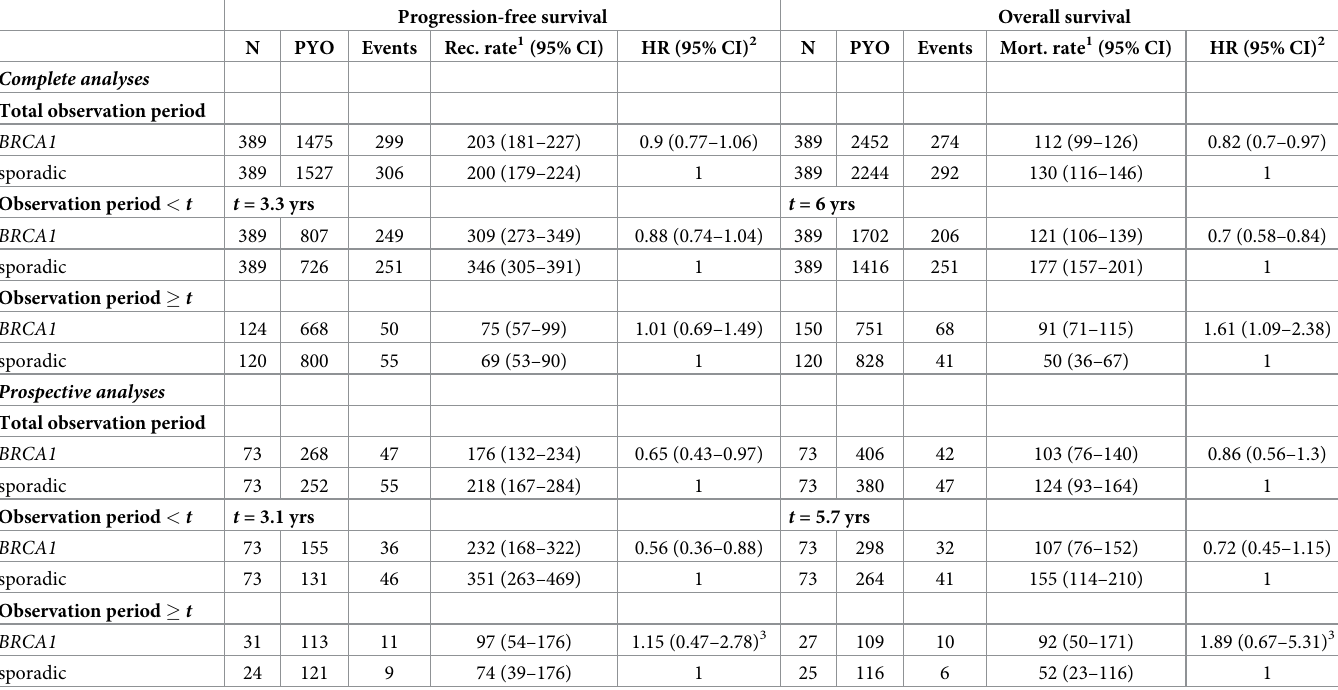
Table 2. Association of BRCA1 germline pathogenic variant status with progression-free survival and overall survival. Progression-free survival Overall